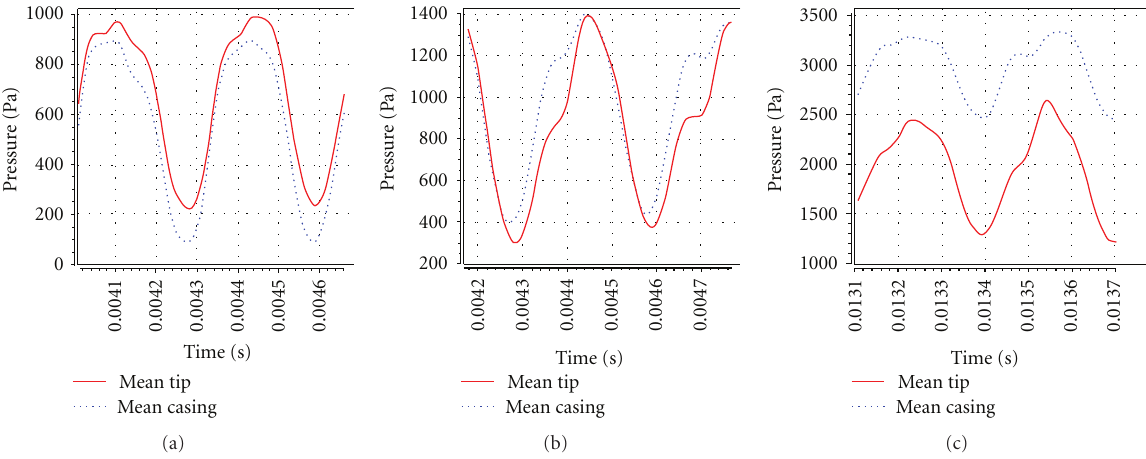
Figure 18: Pressure at the two points located at the mean value of the oscillated blade tip and at a corresponding point on the casing wall, in which both points are rotating with the same angular velocity as the rotor, for (a) 0.5 mm, (b) 1.0 mm, and (c) 1.5 mm